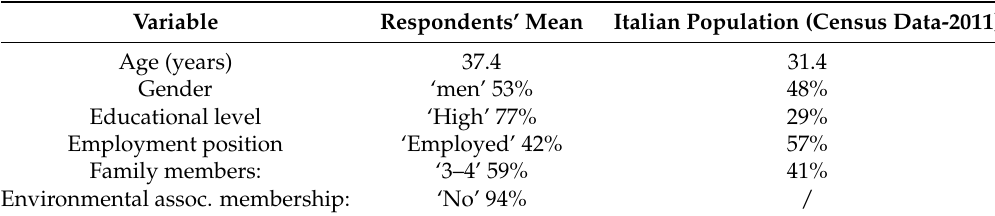
Table 2. Respondents socio-economic